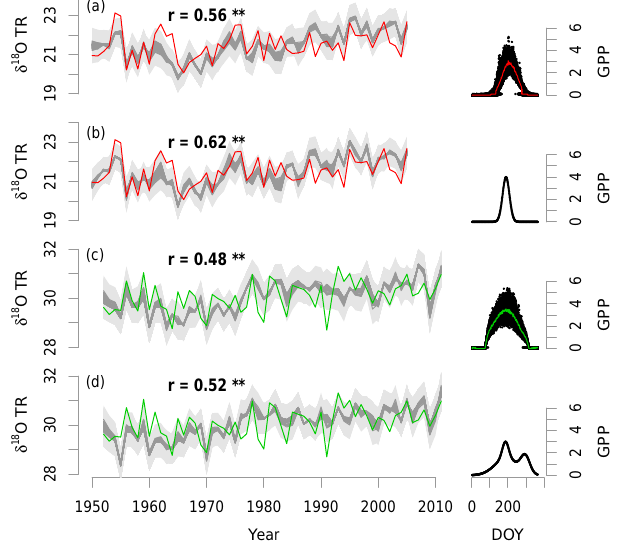
Figure 3. Comparison between observed (red or green) and sim- ulated (grey) δ 18 O TR chronologies in Québec ( a and b ) and Ar- gentina ( c and d ), respectively, using GPP (in g Cm − 2 day − 1 ) sim- ulated by MAIDENiso for each day of the year (DOY) ( a and c ) or synthetized for maximizing correlations ( b and d ). The simulations are based on estimated δ 18 O P series. The 50 different simulations inferred from the Markov chain Monte Carlo (MCMC) chains are in dark grey. The ± 1 root mean square error (RMSE) range is repre- sented in light grey. The mean correlation coefficients are significant at 99% level ( ∗∗